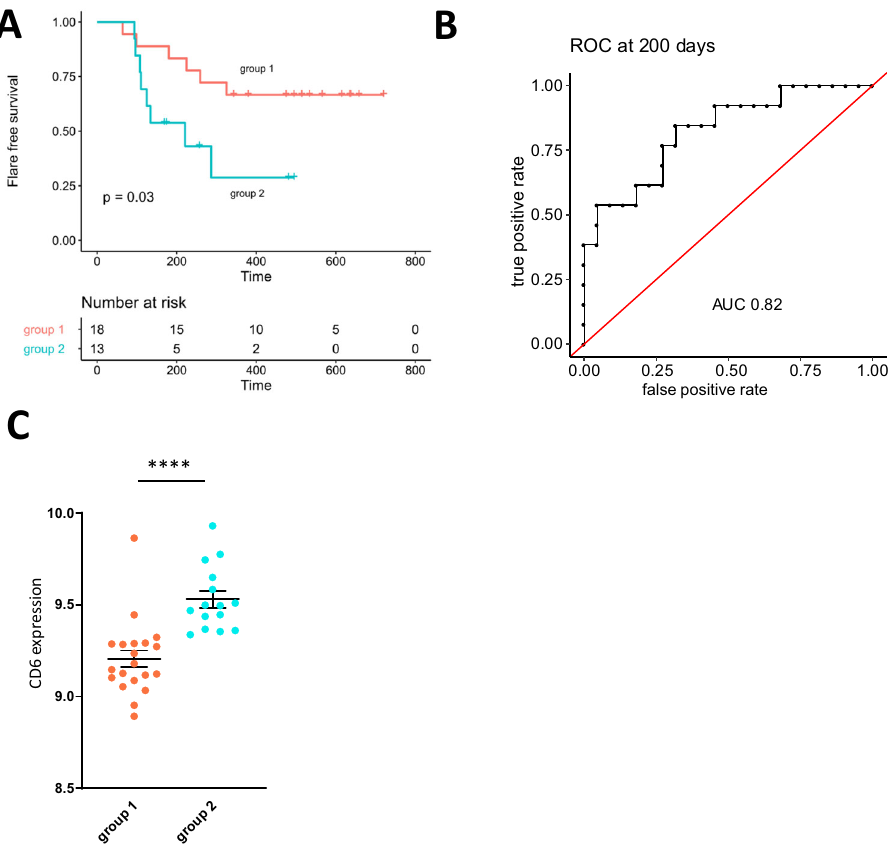
Fig. 5 The Tc17 signature is associated with fl are-free survival. A CD8 + T cell transcriptome data and corresponding clinical data from 31 untreated CD patients were extracted from E-MTAB-331 35 and patients were strati fi ed into two groups based on hierarchical clustering on phenotypic Tc17 signature markers CD6, CD69, CD27, CD39, PD-1, CD26, CD161. Kaplan-Meier-plot depicts fl are-free survival. Log rank test was used to determine statistical signi fi cance. B Time dependent ROC curve for prediction of fl are free survival at 200 days of follow up using a GSVA score based on phenotypic Tc17 signature markers CD6, CD69, CD27, CD39, PD-1, CD26, CD161 and CD8 + T cell transcriptome data and corresponding clinical data from 35 untreated CD patients that were extracted from 35 . C CD6 expression in group 1 and 2 indicated in arbitrary units, n = 35 patients extracted from E-MTAB- 331. Data are presented as mean + / − SEM. Statistical tests used were two-sided. **** p < 0.0001, *** p < 0.001, ** p < 0.01, * p <